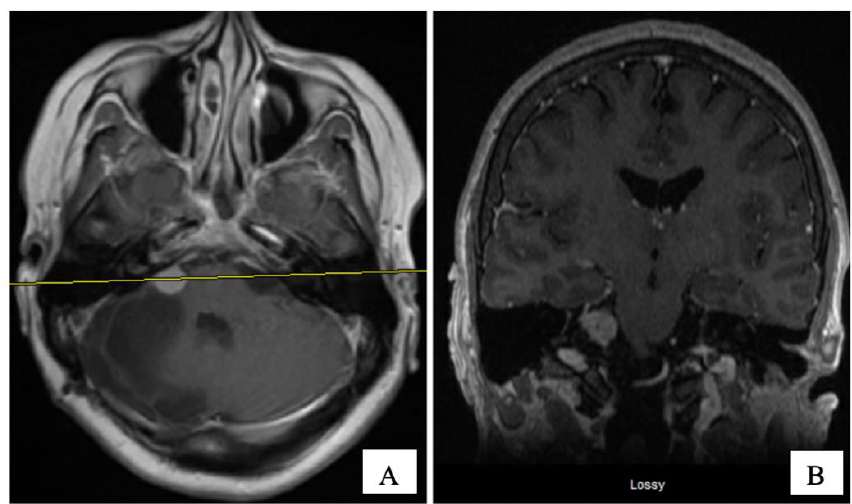
Figure 5. Post-gadolinium T1-W MRI at four years post CK, on axial ( A ) and coronal ( B ) planes. The CPA tumour shrank to 12 × 12 mm.